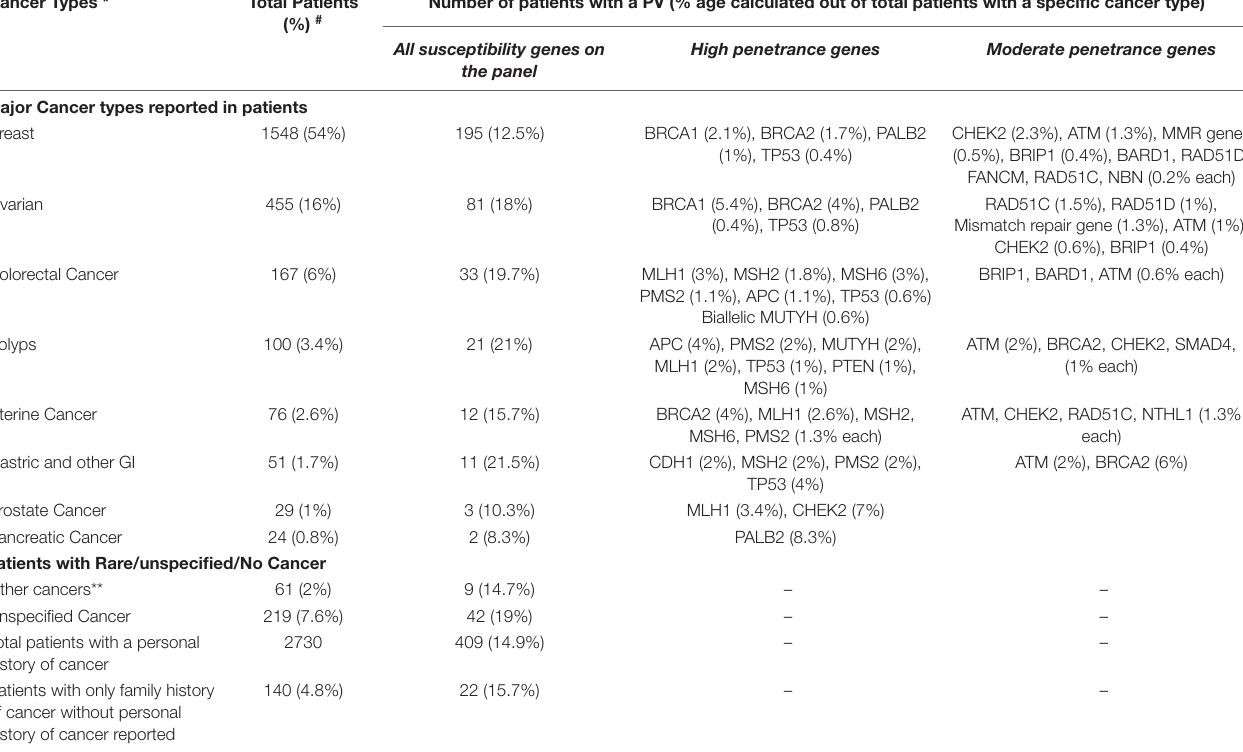
TABLE 2 | Frequency of pathogenic variants (PV) in patients presenting with various cancer types. Cancer Types